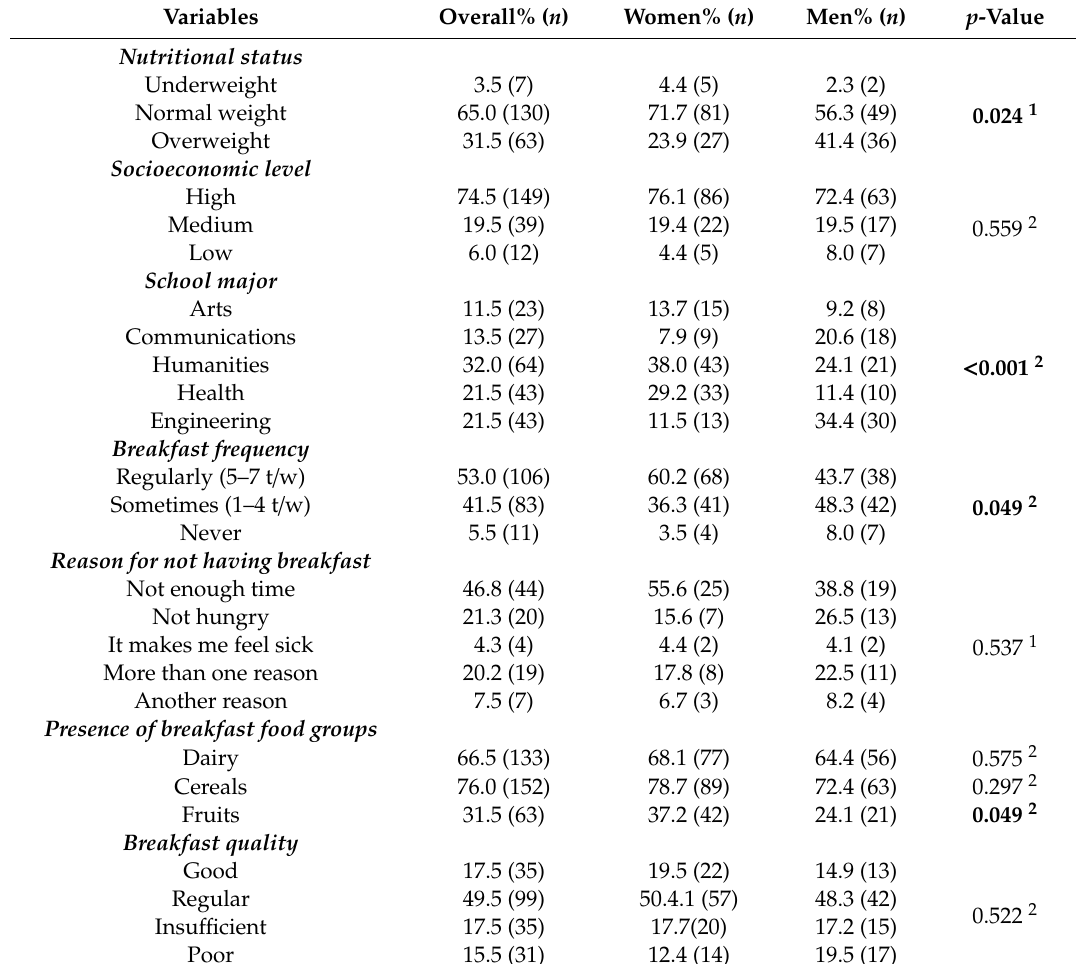
Table 1. General sample